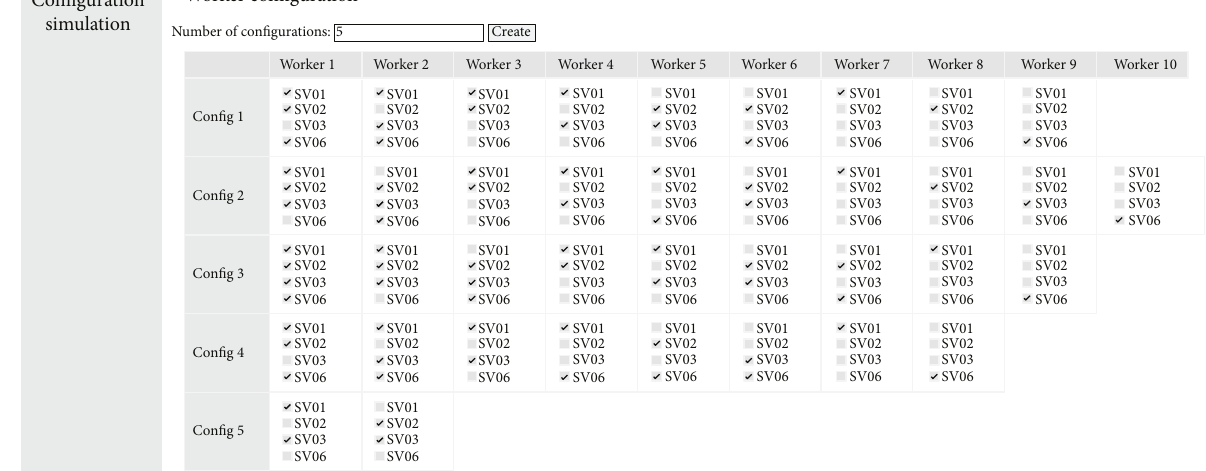
Figure 9: User interface for parameterizing workers ’ skills and